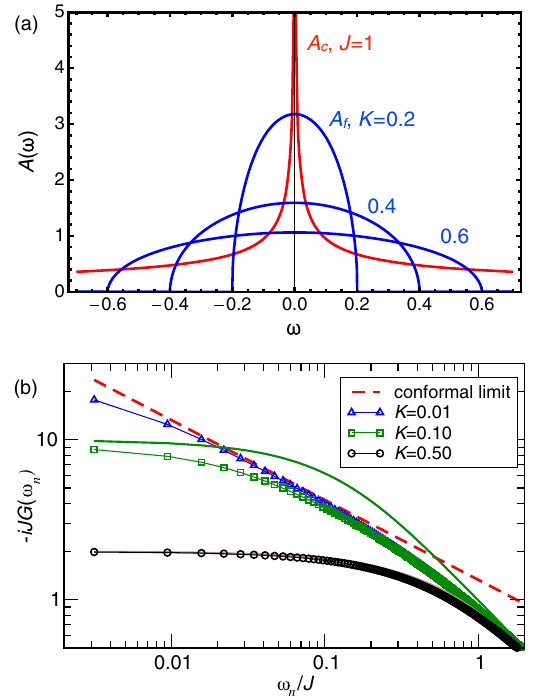
FIG. 2. (a) Spectral functions, measurable in a tunneling experiment, in the conformal (strongly interacting) limit (red lines) and free-fermion limit (blue lines). (b) Numerically evaluated large- N Matsubara Green ’ s functions for J ¼ 1 . 0 , T ¼ 0 . 001 , and different values of K . Red dashed line shows the conformal limit behavior Eq. (3.7) while the thick green and brown lines correspond to free-fermion result Eq. (3.4) with K ¼ 0 . 1 and 0.5,